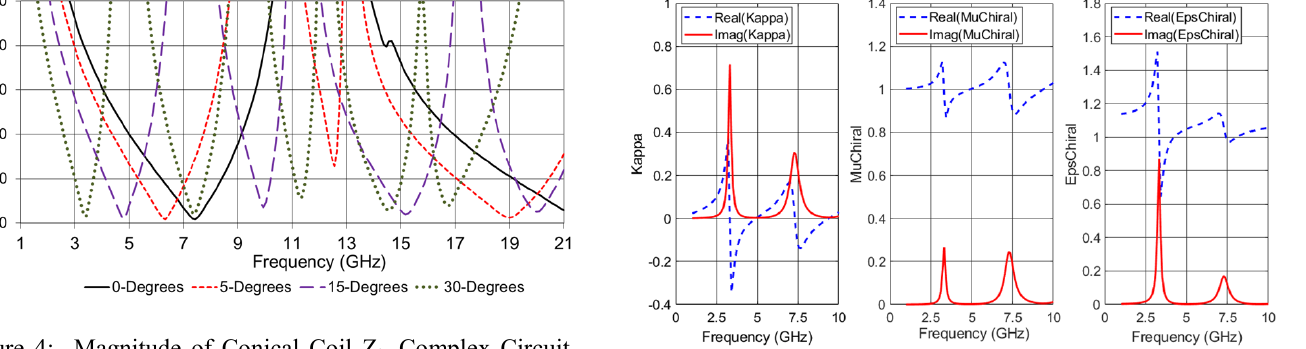
Figure 4: Magnitude of Conical Coil Z lc Complex Circuit Impedance at 0º, 5º, 15º, and 30º Conical Angles.